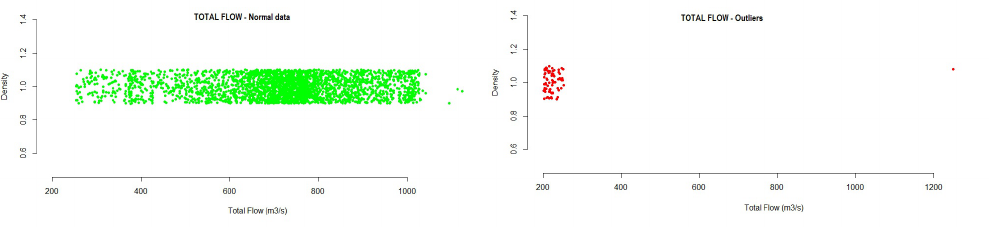
Figure 5. Example of total flow outliers detected for one of the fans in the testing